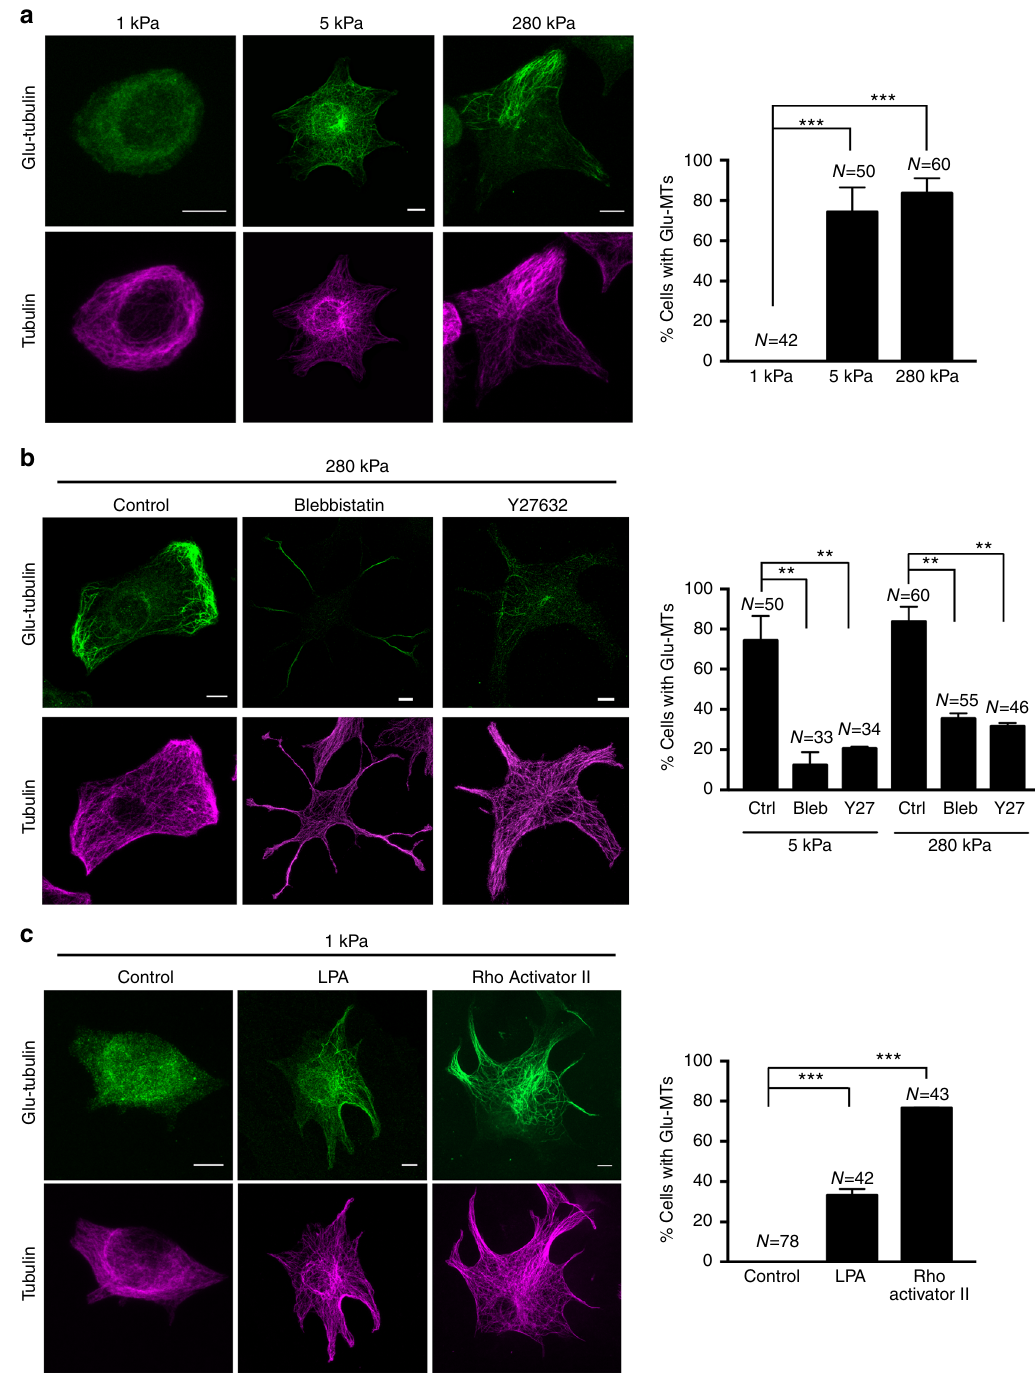
Fig. 4 Actomyosin contractility is required for formation of the detyrosinated-microtubule network. Representative immuno fl uorescence staining images of Glu-tubulin or total alpha-tubulin. Graphs show corresponding percentages of cells exhibiting a Glu-MT network. a Cells were plated on substrates of the indicated stiffness. b Cells on 5 or 280 kPa substrates were treated with Blebbistatin or Y27632. We note that cells treated with Blebbistatin mostly retain Glu-tubulin staining within their long, thin protrusions. Cells were scored for the presence of Glu-MTs within the main cell body. c Cells on 1 kPa substrates were treated with LPA or Rho activator II. Error bars: standard error. N : total number of cells observed in two or more biological replicates. p -values: *** < 0.001, ** < 0.01 by analysis of variance with Bonferroni ’ s multiple comparisons test. Scale bars: 10 μ